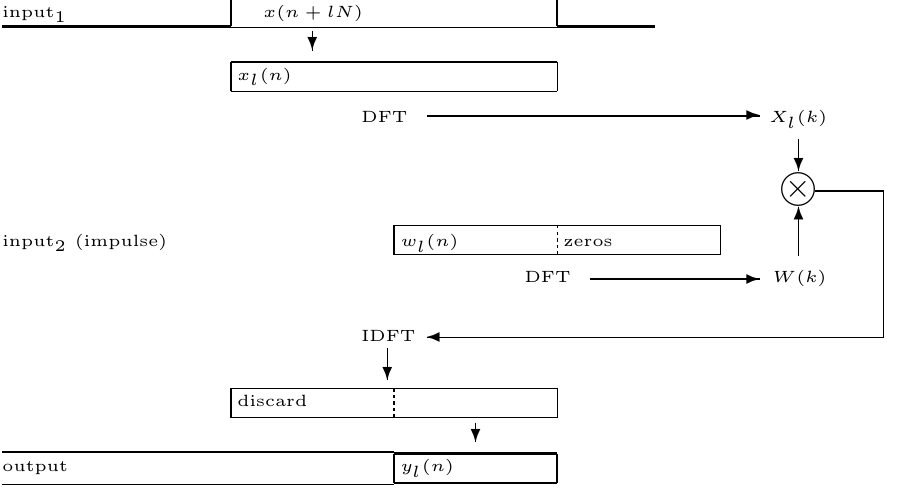
Figure 10. Fast overlap-save convolution.